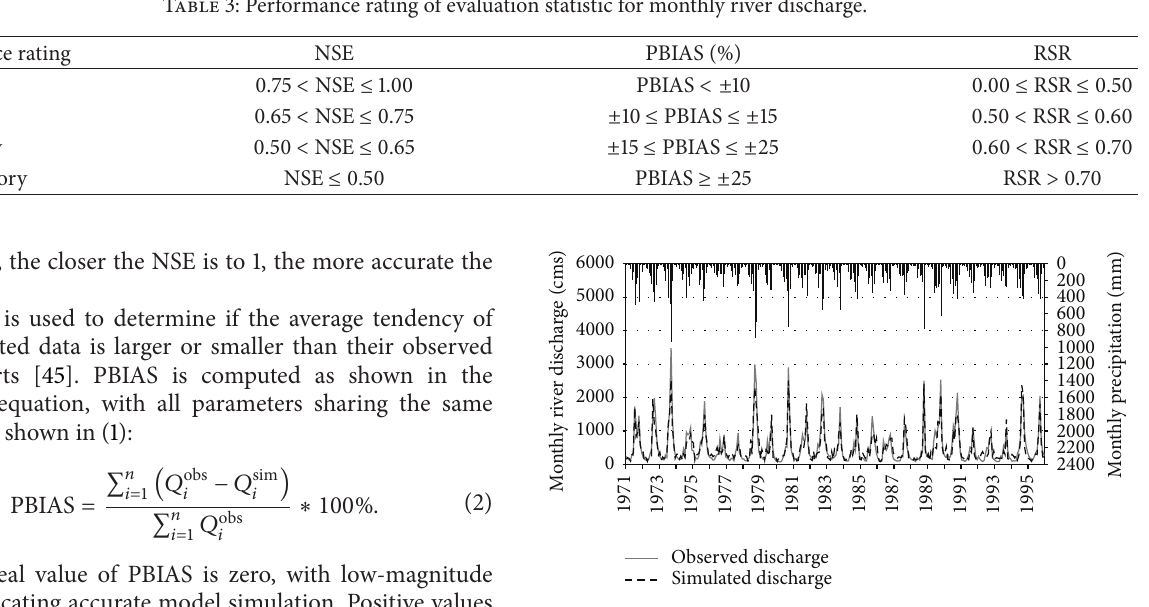
Figure 2: Monthly time series comparison of simulated versus observed river discharge at Yen Thuong Station with reference to monthly precipitation during the 25-year calibration period (1971– 1995).